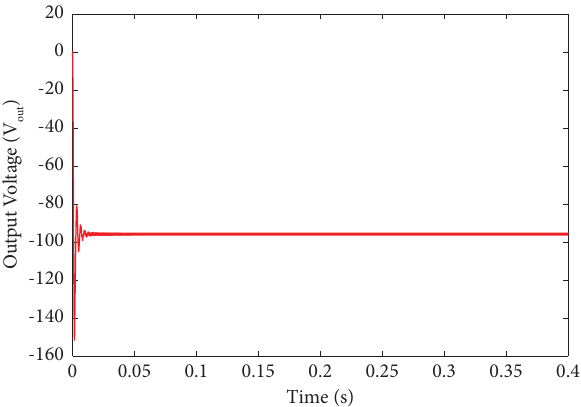
) showing the continuous operation. in